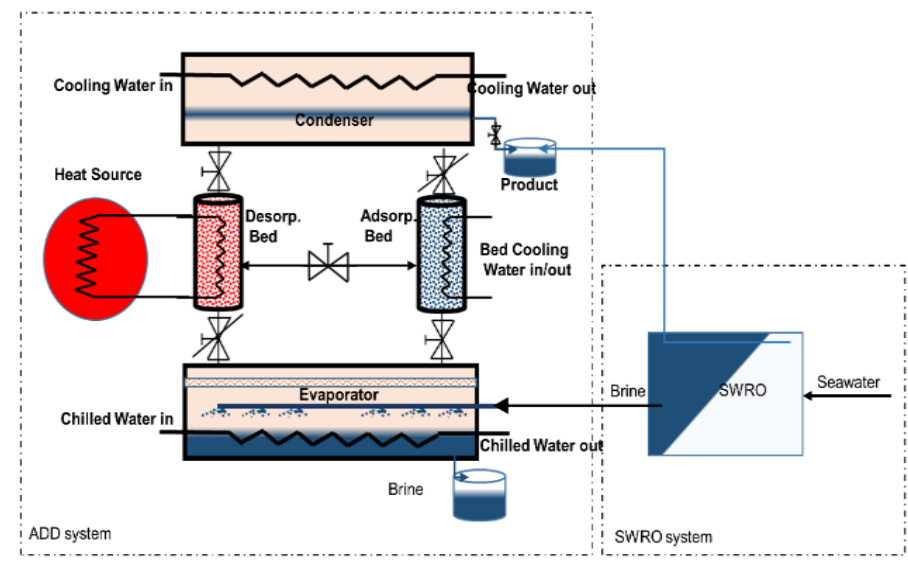
Figure 14. Hybrid of ADD and SWRO.